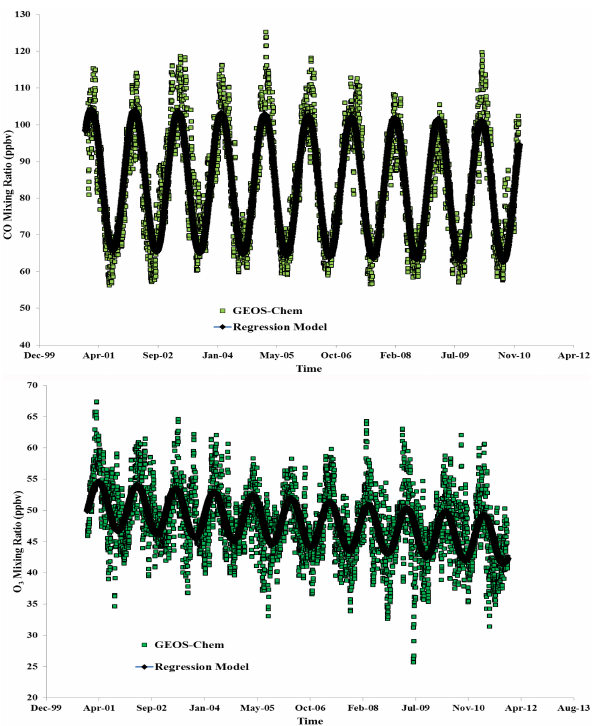
Fig. 6. Regression model fit to the GEOS-Chem simulation results for CO (top) and O 3 (bottom) at PMO.